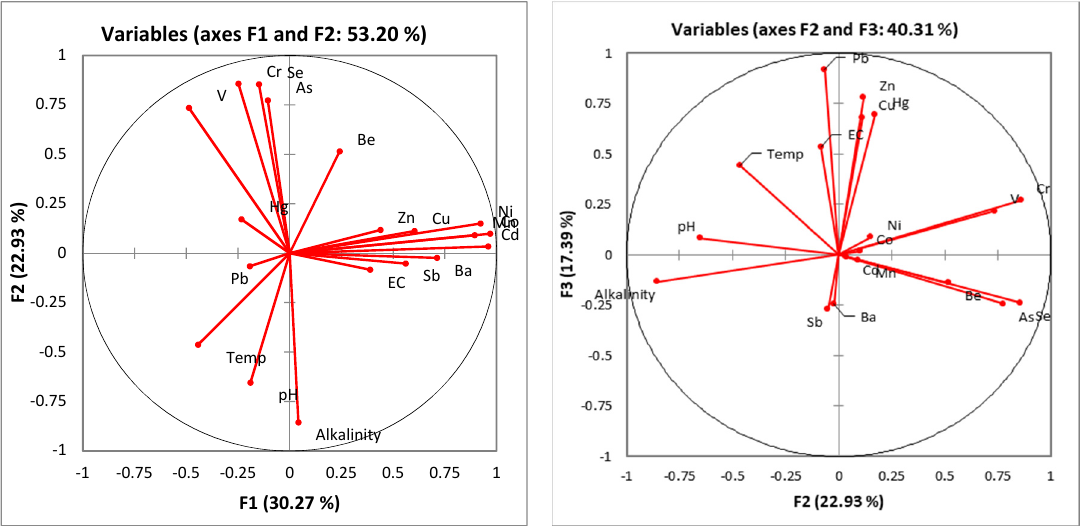
Figure 5. The principal component analysis (PCA) biplots showing the relationships between trace metals in the geothermal spring and borehole samples.